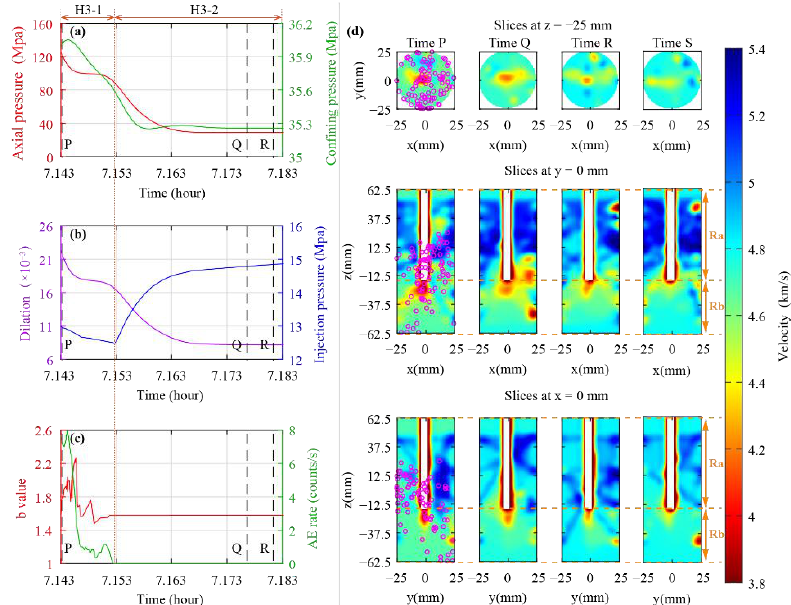
Figure 14. Mechanical response and velocity images of rocks in H3 phase: ( a ) axial (red line) and confining pressure (green line); ( b ) dilation (purple line) and water injection pressure (blue line); ( c ) b-value (red line) and AE rate (green line); ( d ) slices of the 3D ultrasonic velocity images at different times (Times P~R correspond to the times marked by black dotted lines in the left subfigures, and Time S corresponds to 5 min past Time R). The orange dotted line in the subfigures ( d ) represents the boundary between region Ra and Rb.